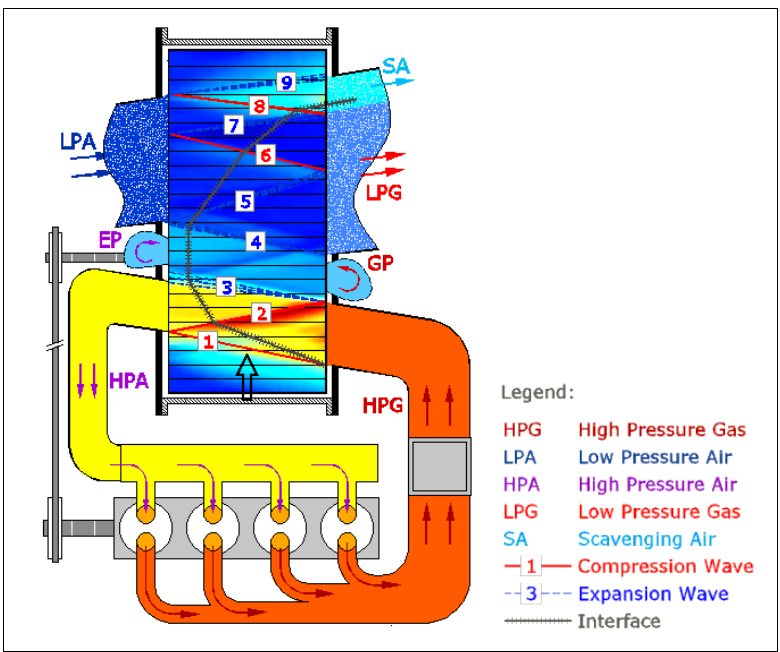
Figure 4. The wave propagation schema as explained in [10].